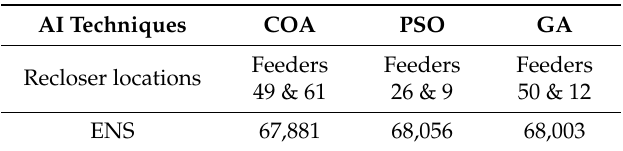
Table 2. A comparative study applied to the base case of IEEE 69 bus system to minimize the energy-not-supplied index